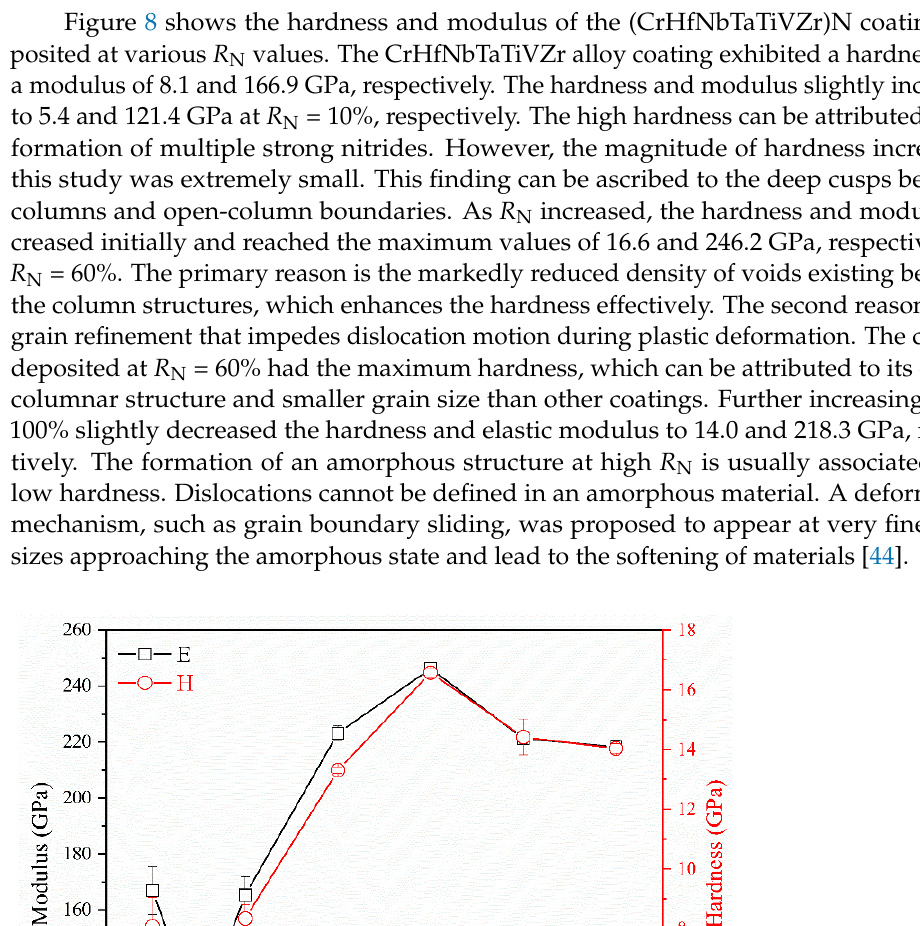
Figure 7. SAD patterns of (CrHfNbTaTiVZr)N coatings deposited at various R N .